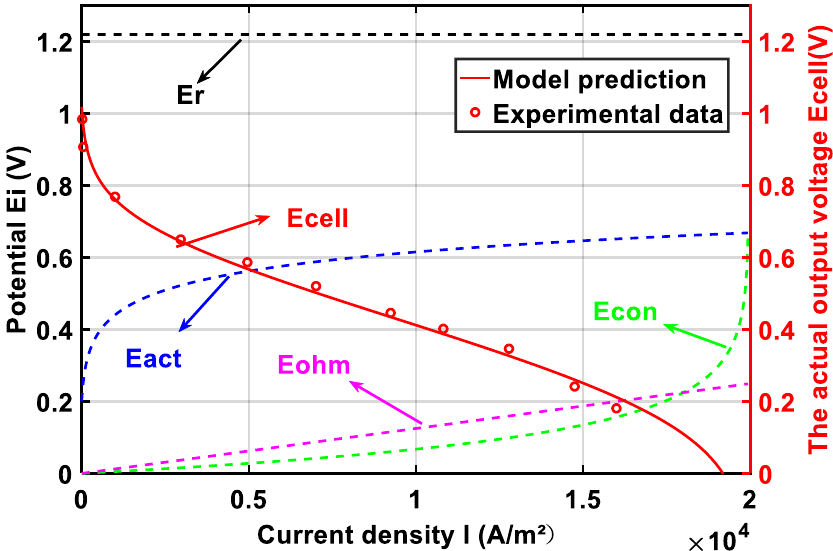
Figure 1. Comparisons of the HT-PEMFC output voltage between the modeling results and the experimental